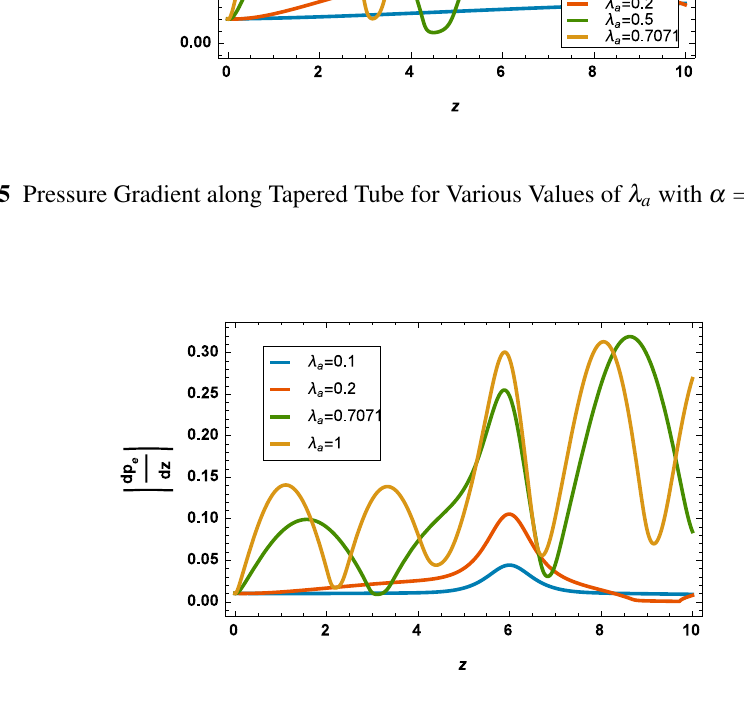
Fig. 6 Pressure Gradient along Locally Constricted Tube for Various Values of λ a with α = 20 , β = 0 . 5